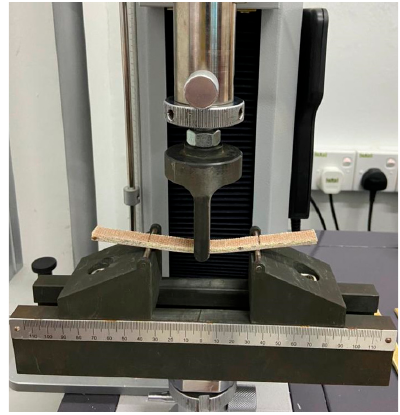
Figure 2. Photos of flexural loading and samples during flexural test.